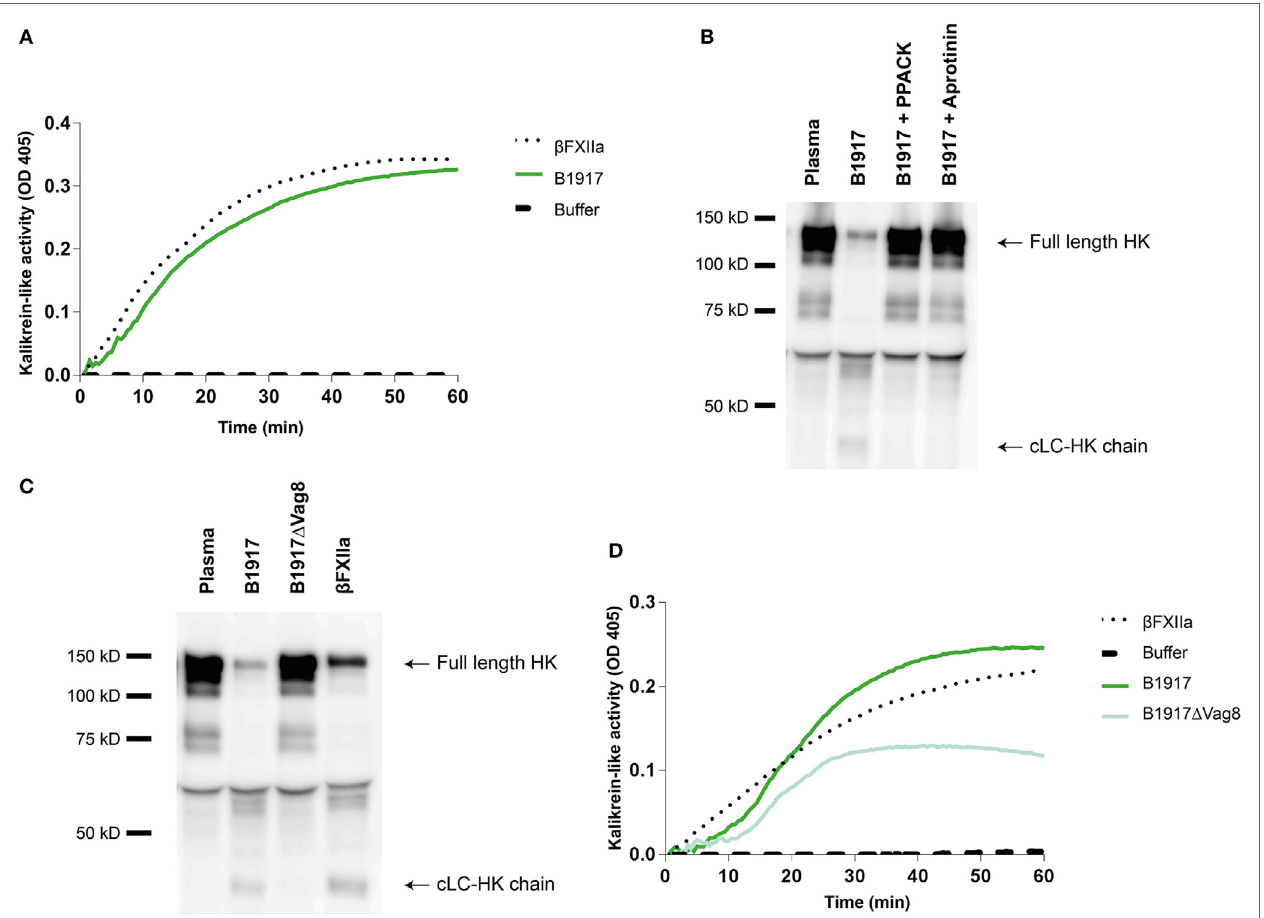
FigUre 4 | Bordetella pertussis activates the contact system mainly by Virulence associated gene 8 (Vag8) production. (a) B. pertussis wild type strain B1917 (3 × 10 7 CFU) induces similar kallikrein-like activity in 60% plasma compared to addition of 0.5 µg/mL β FXIIa. (B) Contact system activation by B. pertussis wild type strain B1917 was also shown by immunoblot. 50% plasma was incubated for 60 min with B. pertussis wild type strain B1917 (2 × 10 9 CFU) alone or in combination with the contact system inhibitors d -phenylalanyl-prolyl-arginyl chloromethyl ketone (PPACK) or aprotinin and analyzed using anti-high-molecular-weight-kininogen (HK). Incubation with B. pertussis wild type strain B1917 resulted in almost complete cleavage of the ~120 kDa full length HK as indicated by the appearance of the ~46 kDa cLC-HK chain. This feature was not observed in the presence of the inhibitors. (c) To determine whether Vag8 production was involved in contact system activation by this pathogen, 50% plasma was incubated either with B. pertussis wild type strain B1917 or with the knockout strain B1917 Δ Vag8 (2 × 10 9 CFU) and analyzed using anti-HK. The B. pertussis knockout strain B1917 Δ Vag8 was unable to activate the contact system as no cleavage of the ~120 kDa full length HK was detected. (D) This was also shown by the decreased kallikrein-like activity in 60% plasma upon incubation with the knockout strain B1917 Δ Vag8 (3 × 10 7 CFU) compared to the B. pertussis wild type strain B1917. Panels a–D are representative of three separate